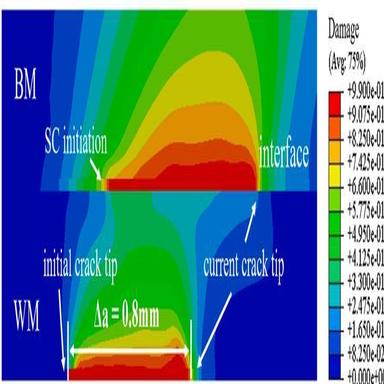
The formation of second crack in simulation for CT specimen at M = 1.4 under h = 0.4 mm.